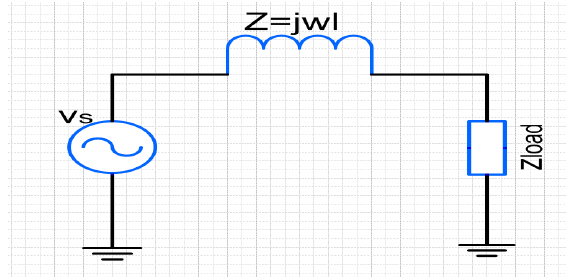
Figure 6. Configuration of reactor type FCL.